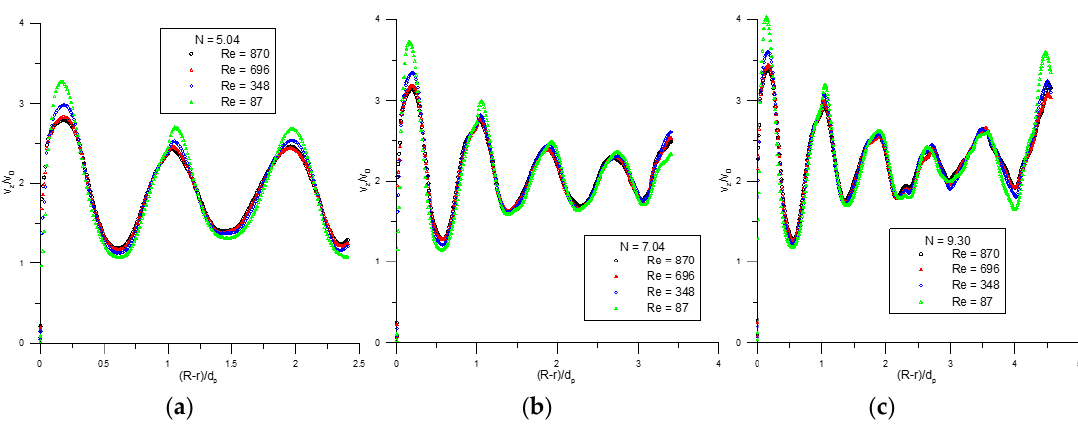
Figure 6. Comparison of all four interstitial velocity profiles for each of three values of ( a ) N : 5.04, ( b ) N : 7.04 and ( c ) N : 9.30.